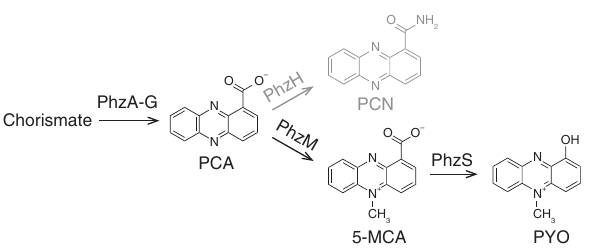
Figure 1 | P. aeruginosa phenazines investigated in this study. Phenazine biosynthesis, limited to the pathway producing PCA, PCN, 5-MCA and PYO. Arrows are labelled with the phenazine biosynthetic enzymes. PCN is shown in grey as all strains used in this study are D phzH